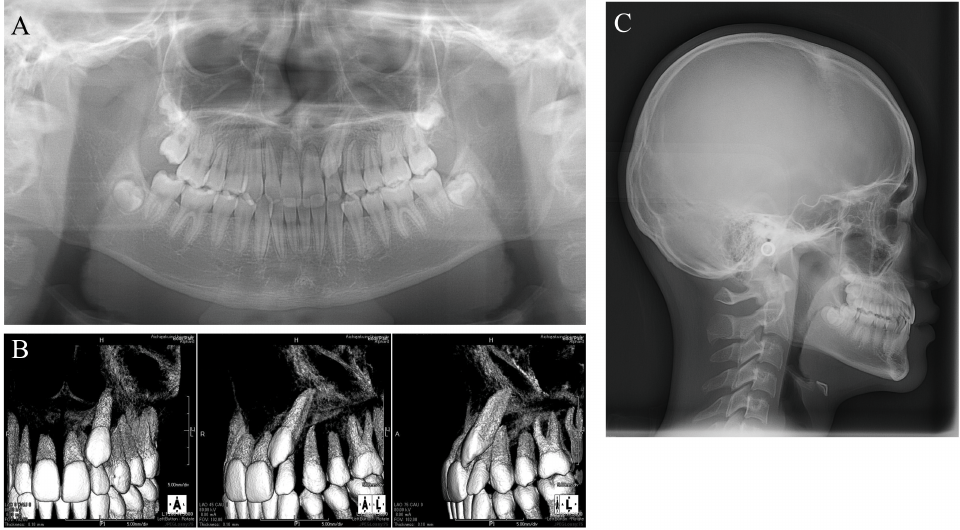
Figure 3. Initial radiographs. ( A ) Panoramic radiograph. ( B ) Cone-beam computed tomography. ( C ) Lateral cephalogram (age, 14 years 4 months).